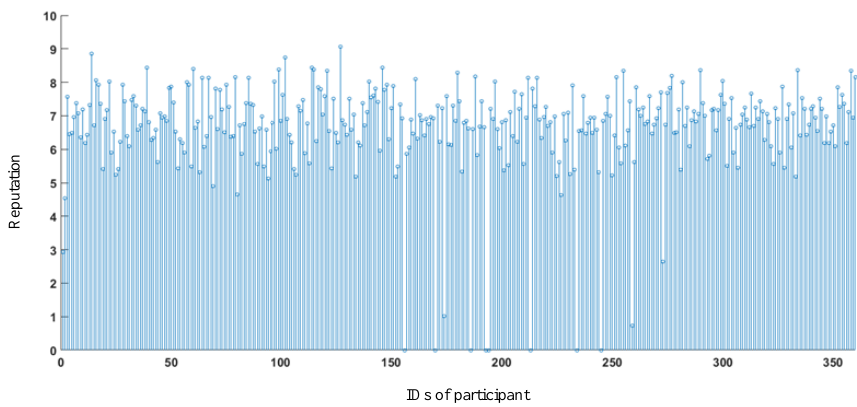
Figure 15. Reputation accumulation of